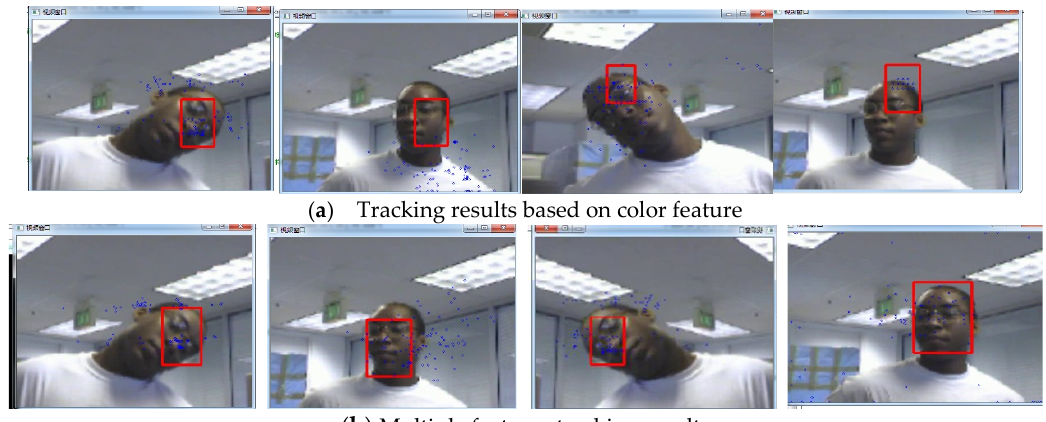
Figure 14. Tracking results under the background changes.